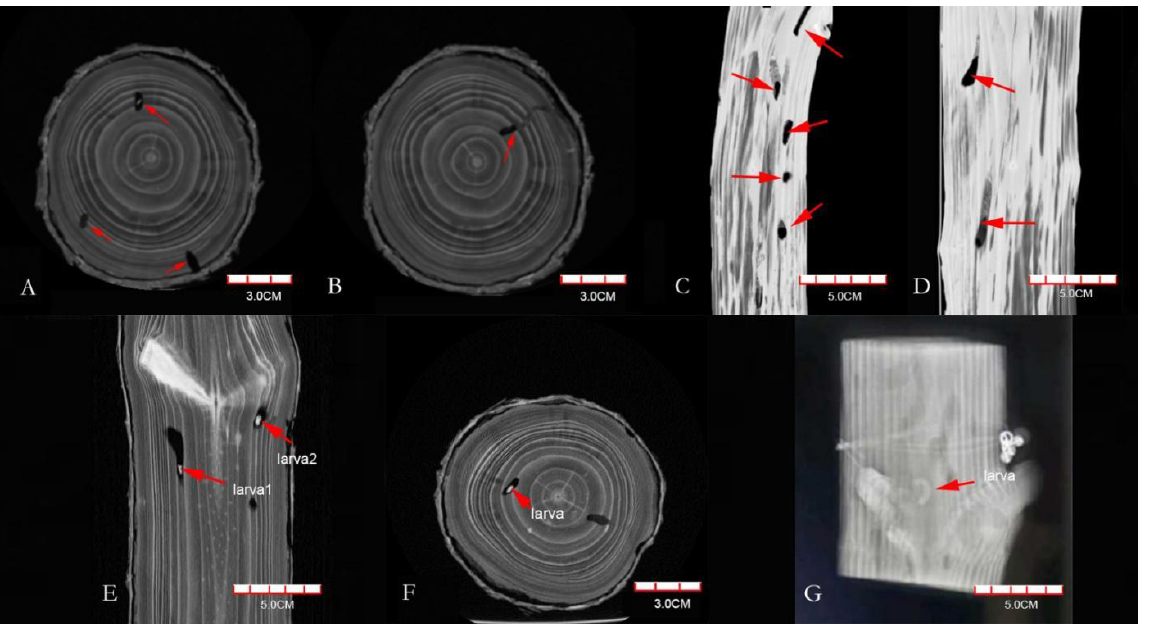
Figure 1. CT scanning images of Pinus densiflora segments (( A ) and ( B ) are on the transverse plane, ( C ) and ( D ) are on the longitudinal plane, and ( E ),( F ) and ( G ) are Monochamus alternatus larvae (red